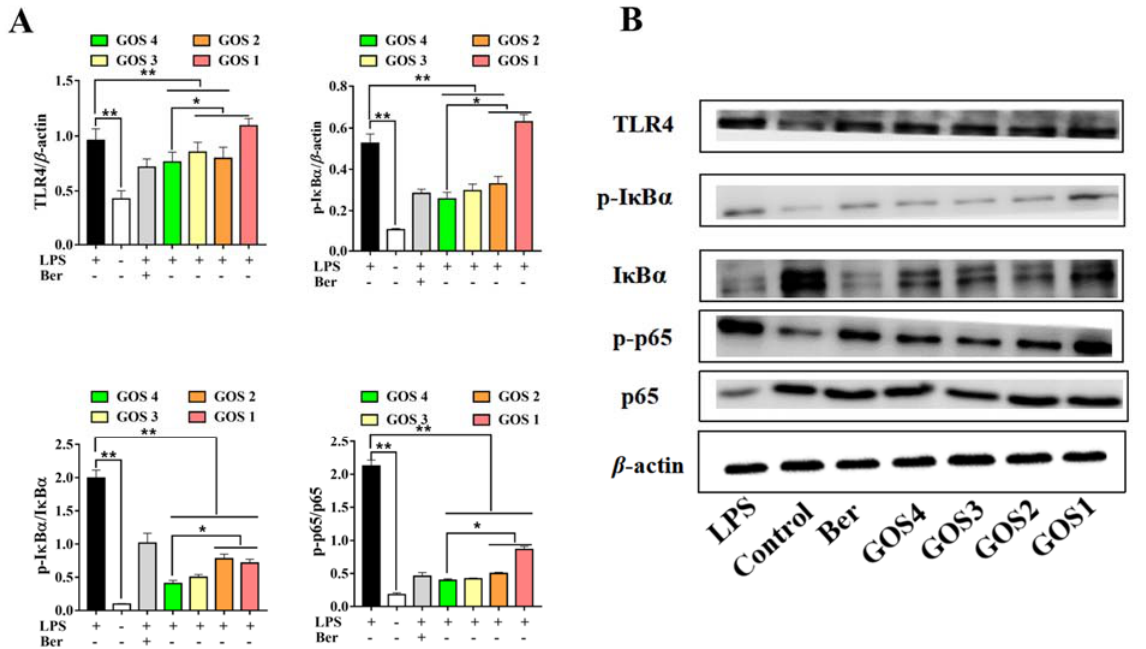
Figure 6. Effects of GOS1-4 on the TLR4/NF- κ B signaling pathway in LPS-induced RAW264.7 macrophages: ( A ) The levels of protein expression were assessed by western blot; ( B ) Representative image of western blotting. One-way ANOVA combined with Duncan’s test, * p < 0.05, ** p < 0.01, the difference was statistically significant.